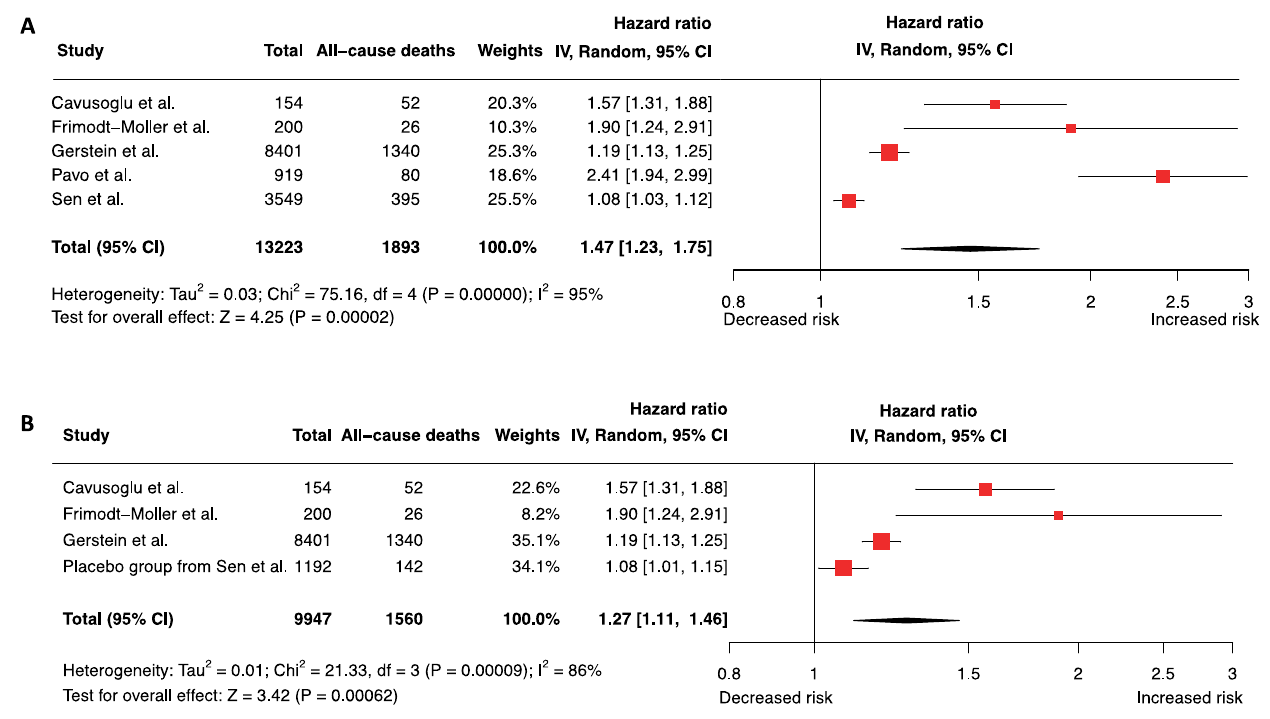
Figure 3. Pooled hazard estimates of all-cause mortality associated with increased circulating GDF-15 levels ( A ) including and ( B ) excluding the unadjusted study by Pavo et al. and canagliflozin received patients (2357 of 3549) from Sen et al. After removal of the unadjusted study, the I 2 decreased 95% to 86%, the pooled effect size reduced from 1.47 to 1.27.